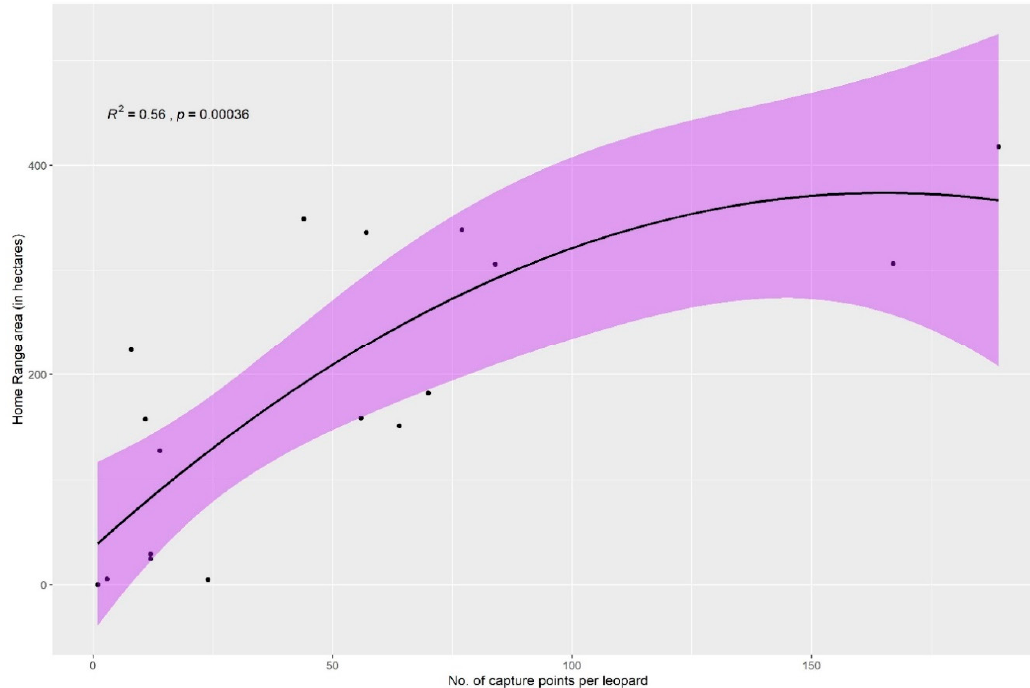
Figure 13. Saturation curve of home ranges of leopards (solid line) with respect to the number of capture points per leopard with 95% confidence interval (shaded area).